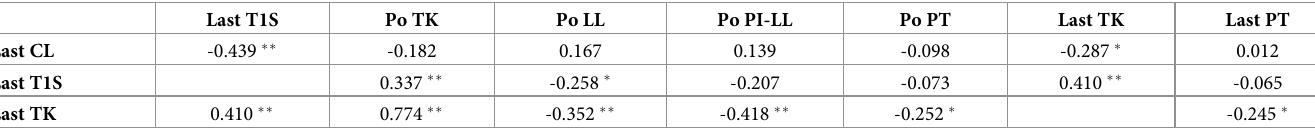
Po, postoperative (2 months after surgery); Last, last follow-up (2 years after surgery); CL, cervical lordosis; T1S, T1 slope; TK, thoracic kyphosis; LL, lumbar lordosis; PI, pelvic incidence; PT, pelvic tilt.